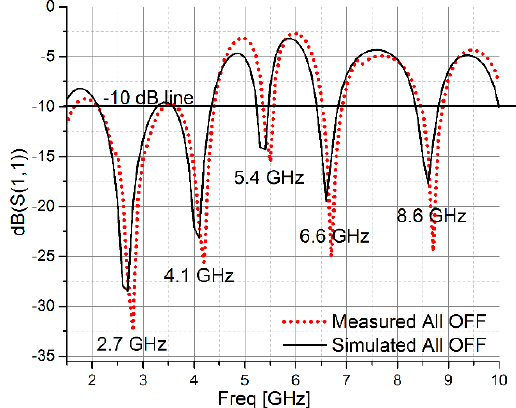
Figure 11. Measured and simulated S 11 for all switches OFF.